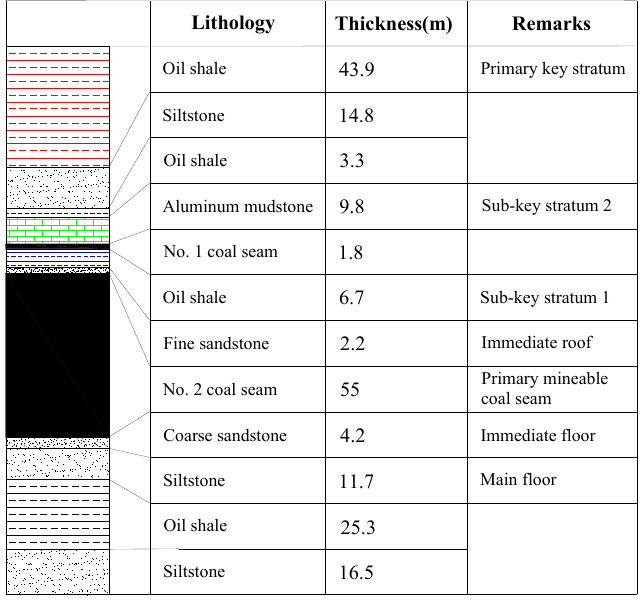
Figure 2. Generalized stratigraphic column of the geological borehole.